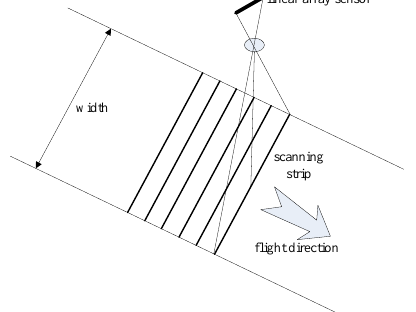
Figure 1. linear array image acquisition